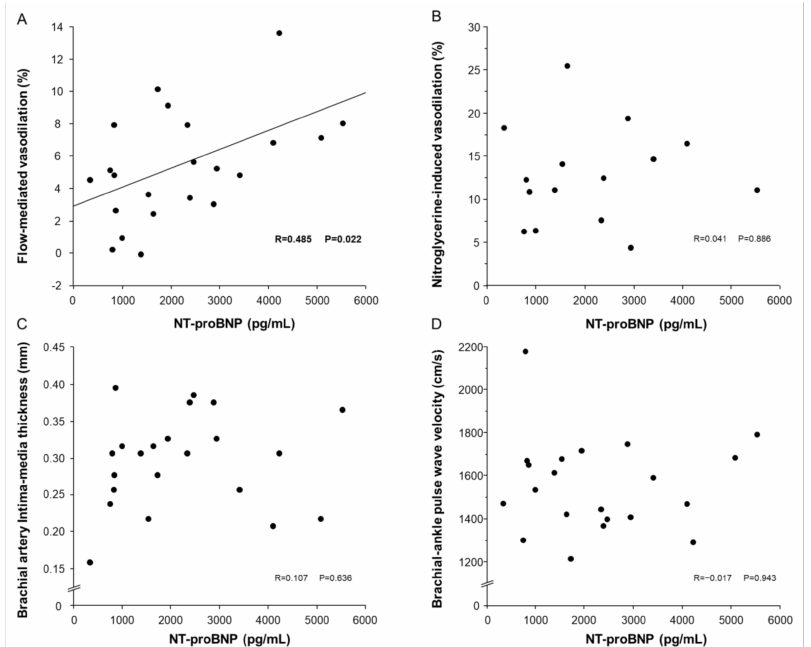
Figure 2. Association between N-terminal pro-brain natriuretic peptide (NT-proBNP) and flow mediated vasodilation (FMD). Scatter plots show the relationship of NT-proBNP with FMD ( A ) and nitroglycerine-induced vasodilation ( B ), brachial intima-media thickness ( C ) and brachial-ankle pulse wave velocity ( D ) in patients with wild-type transthyretin amyloid